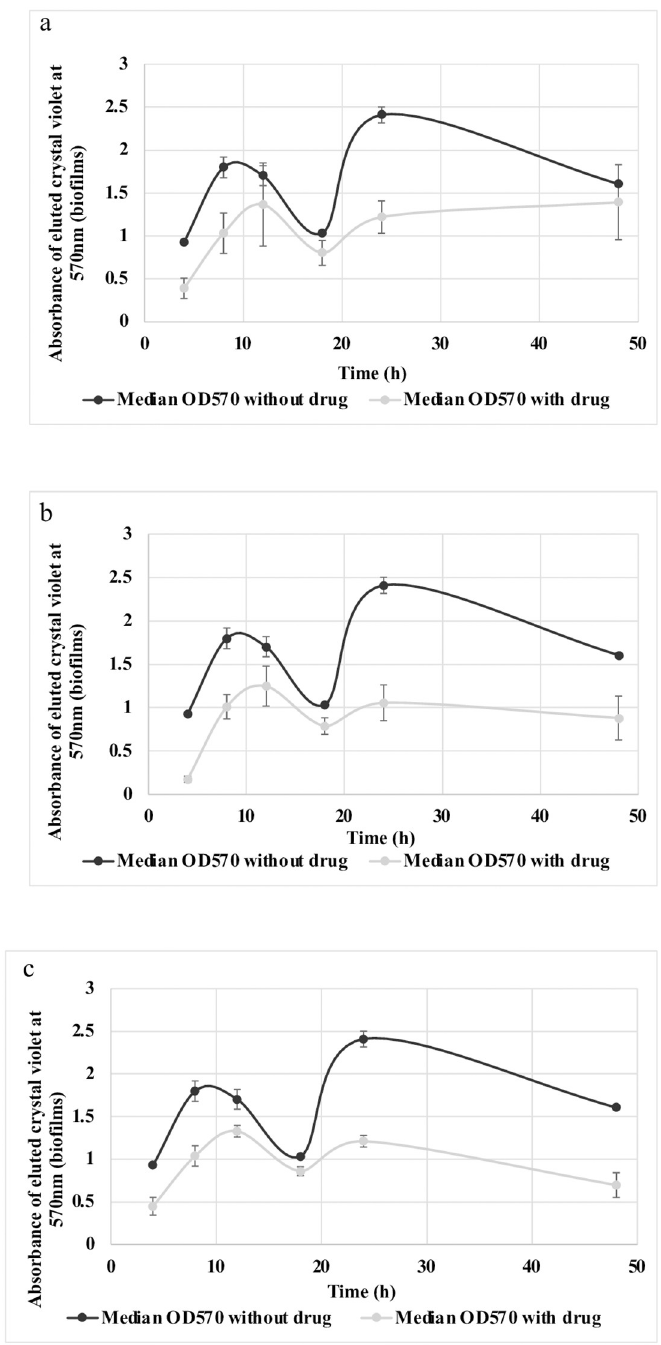
Fig 5. Time course assay of 042 biofilm by 3 hits at 5 μ M shows inhibition is high at the earlier time points but highest at the later phase in: (a) MMV688978 (b) MMV687800 (c) MMV688990. Error bars represent the range of